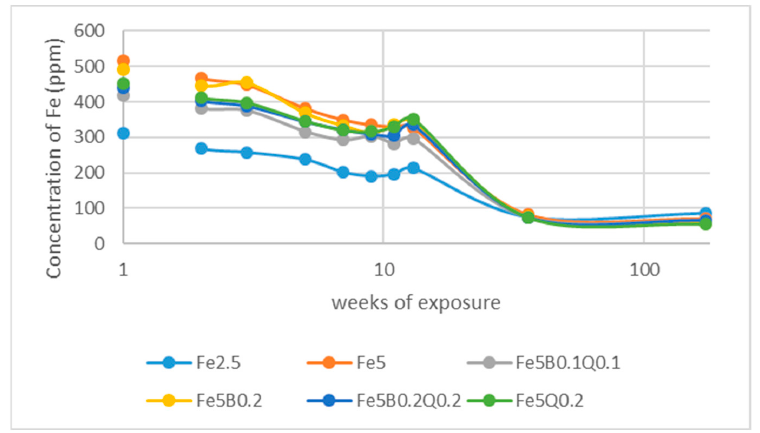
Figure 8. Mean concentrations of iron on the surface of iron(II)-sulphate-treated Norway spruce samples following outdoor exposure. The compositions of treatments are presented in Table 1. The x -axis is a logarithmic scale.